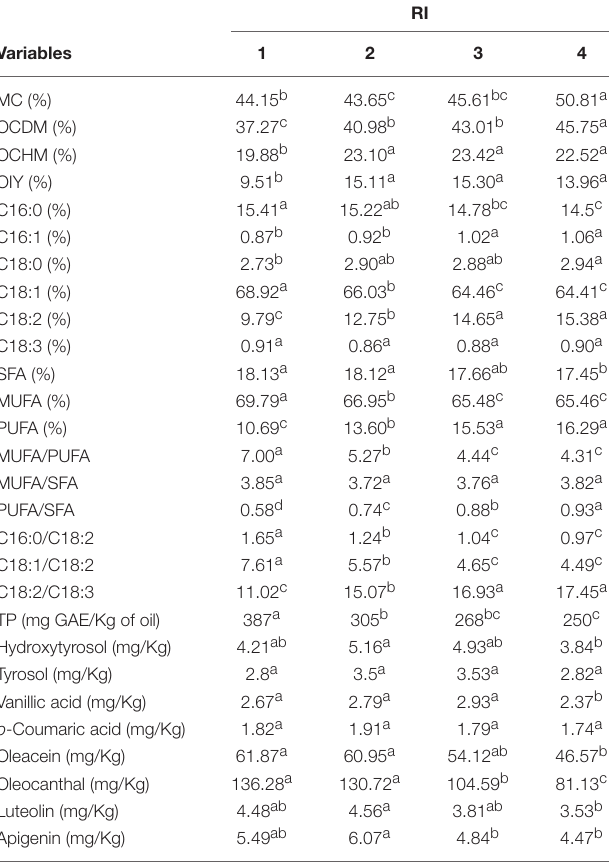
TABLE 4 | Evolution of OC, fatty acids and phenolic compounds traits along ripening.